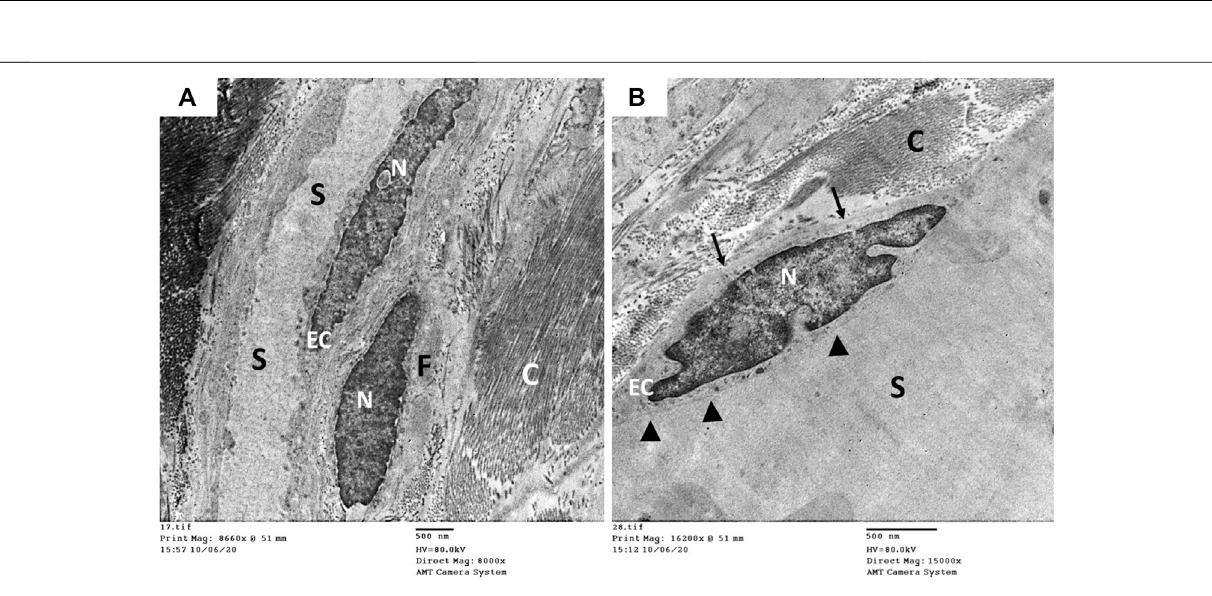
Frontiers in Physiology |